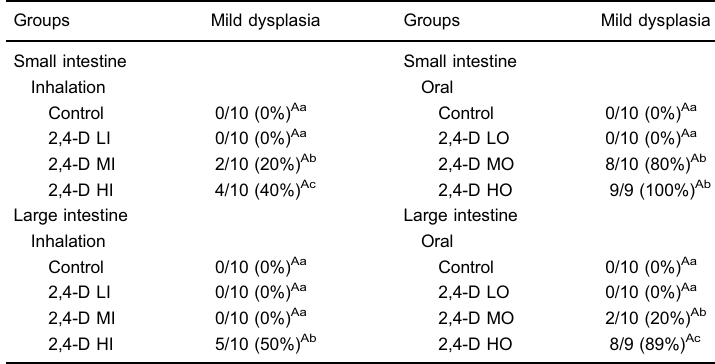
Table 2. Incidence of mild dysplasia in the small and large intestines in the experimental groups (n=79). Groups Mild dysplasia Groups Mild dysplasia Small intestine Small intestine Inhalation Oral Control 0/10 (0%) Aa Control 0/10 (0%) Aa 2,4-D LI 0/10 (0%) Aa 2,4-D LO 0/10 (0%) Aa 2,4-D MI 2/10 (20%) Ab 2,4-D MO 8/10 (80%) Ab 2,4-D HI 4/10 (40%) Ac 2,4-D HO 9/9 (100%) Ab Large intestine Large intestine Inhalation Oral Control 0/10 (0%) Aa Control 0/10 (0%) Aa 2,4-D LI 0/10 (0%) Aa 2,4-D LO 0/10 (0%) Aa 2,4-D MI 0/10 (0%) Aa 2,4-D MO 2/10 (20%) Ab 2,4-D HI 5/10 (50%) Ab 2,4-D HO 8/9 (89%) Ac Data are reported as number and percent. 2,4-D LI: Group exposed to low concentration of 2,4-dichlorophenoxyacetic acid (2,4-D) by inhalation; 2,4-D LO: Group exposed to low concentration of 2,4-D orally; 2,4-D MI: Group exposed to the moderate concentration of 2,4-D by inhalation; 2,4-D MO: Group exposed